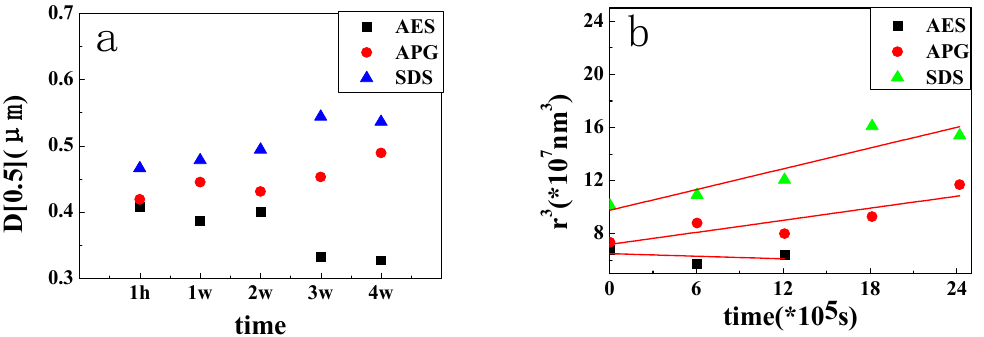
Figure 3. ( a ) the comparison of the mean droplet size of three emulsions over time; ( b ) the fitting curve of the mean droplet size over time.